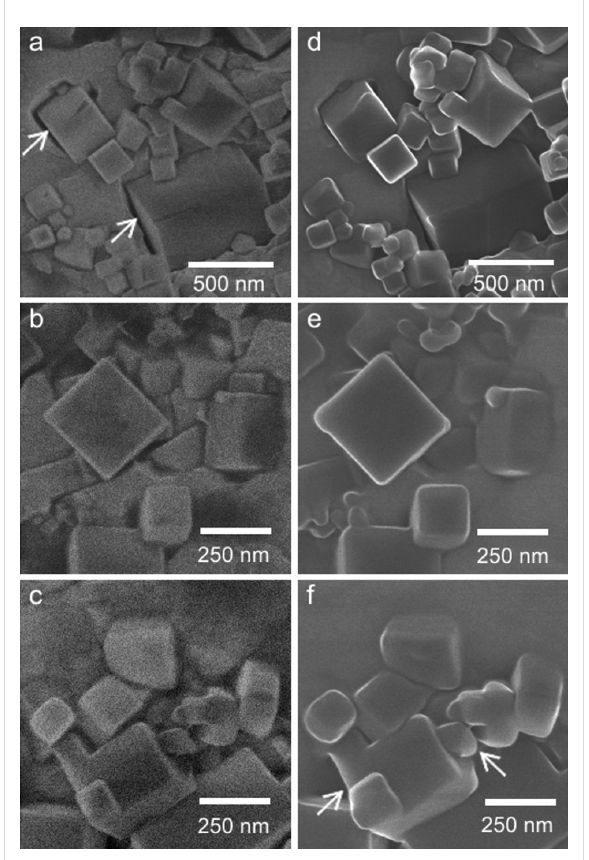
Figure 2: Morphological changes of MgO cubes under high-vacuum conditions. (a–c) High-magnification HIM images of MgO cubes em- bedded in an indium foil after 1 hour and (d–f) 4 days in the HIM chamber (chamber pressure p < 3·10 − 7 mbar). Significant volume increase, rounding of the edges, and partial fusion of the particles was observed (see arrows in micrographs). (HIM SE images digitally magnified from Figure